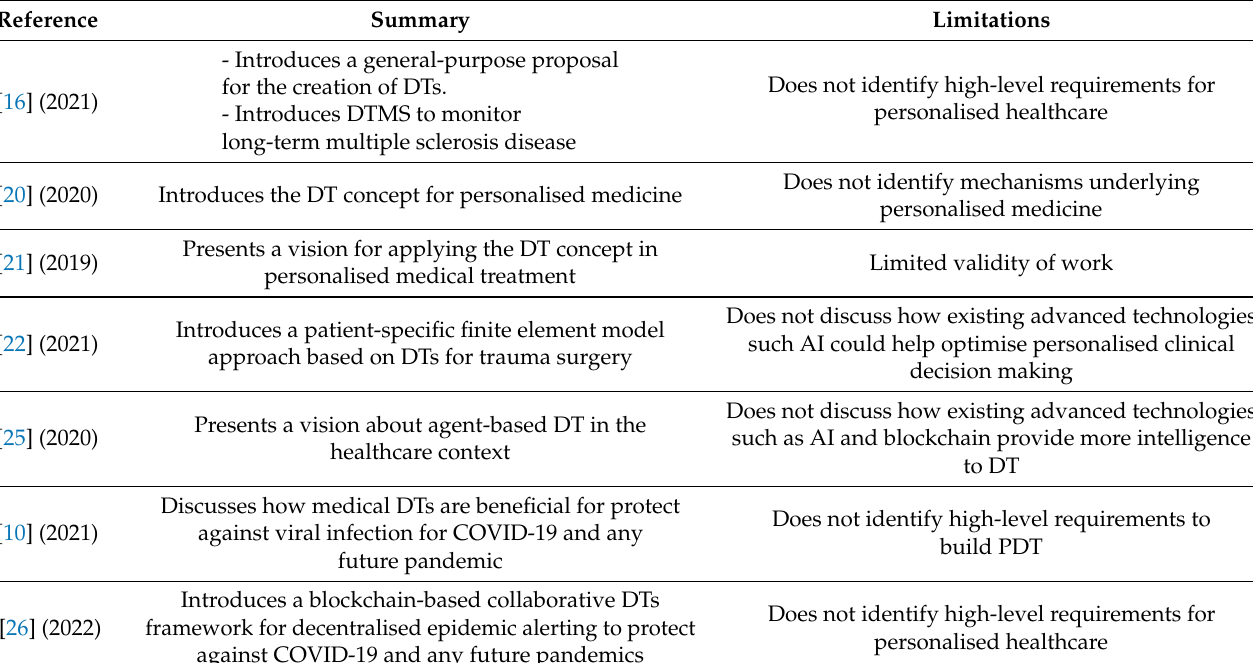
Table 1. Summary of previous research works in personalised healthcare and their